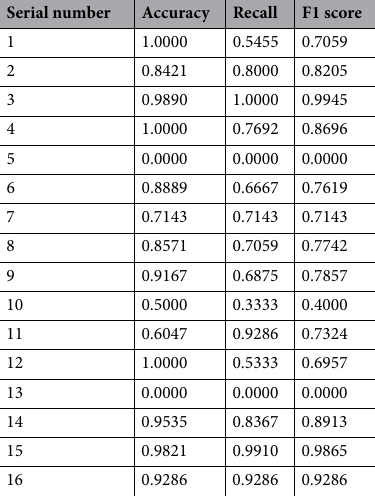
Table 7. The results of the TF-IDF-LR model’s shallow labeling by category.